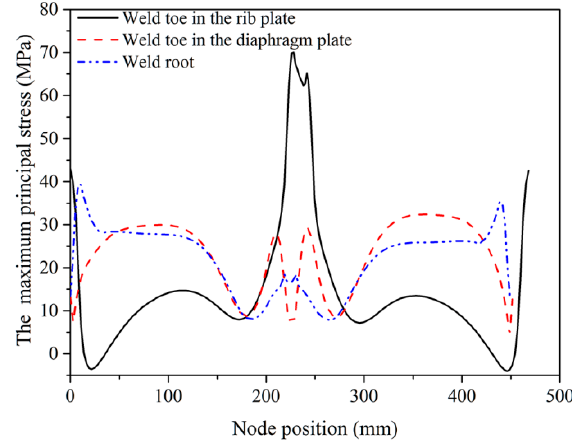
Figure 6. Stress–ode position curves of the rounded welding region in the sub-model (Node position is along the welding direction).